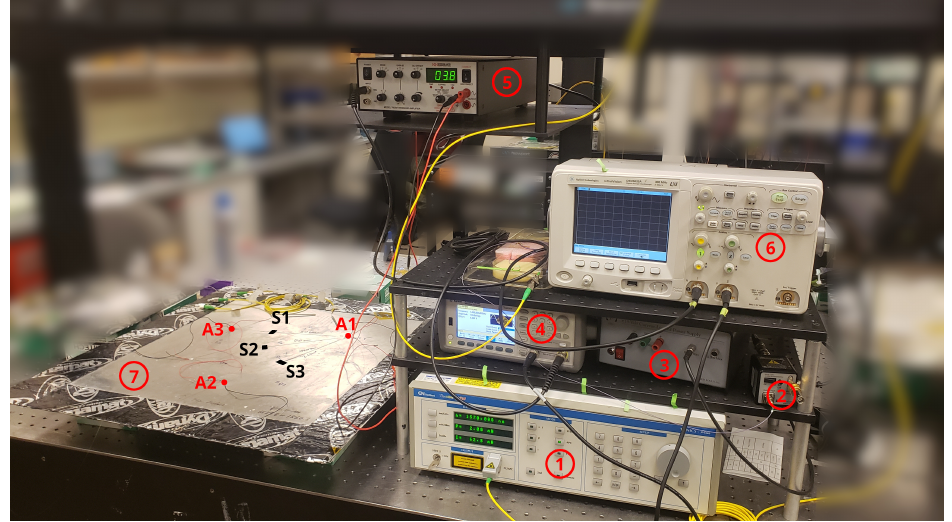
Figure 3. Experiment Setup. 1—Tunable Laser, 2—Photodetector, 3—Power Supply, 4—Waveform Generator, 5—Voltage Amplifier, 6—Oscilloscope, 7—Experiment Sample. 8—Actuators (A1, A2, A3), 9—Sensors (S1, S2,